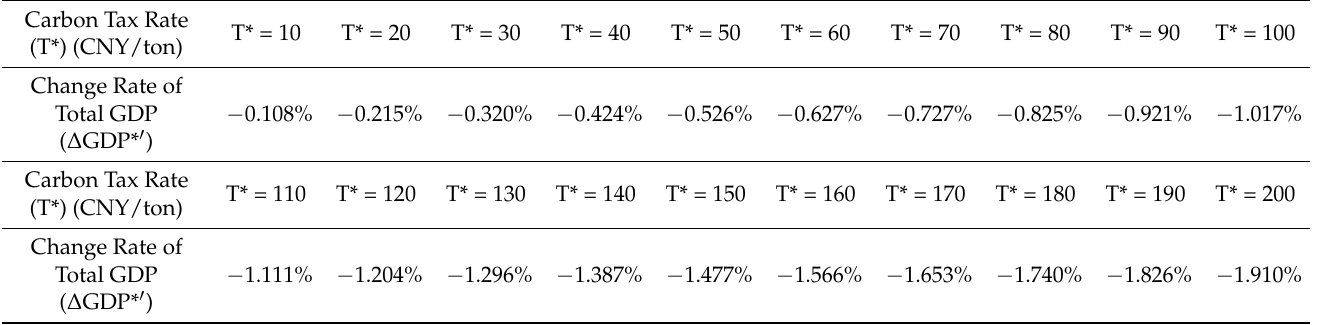
Table 3. Relationship between carbon tax and GDP. Impact of different carbon tax rates on the changes of total